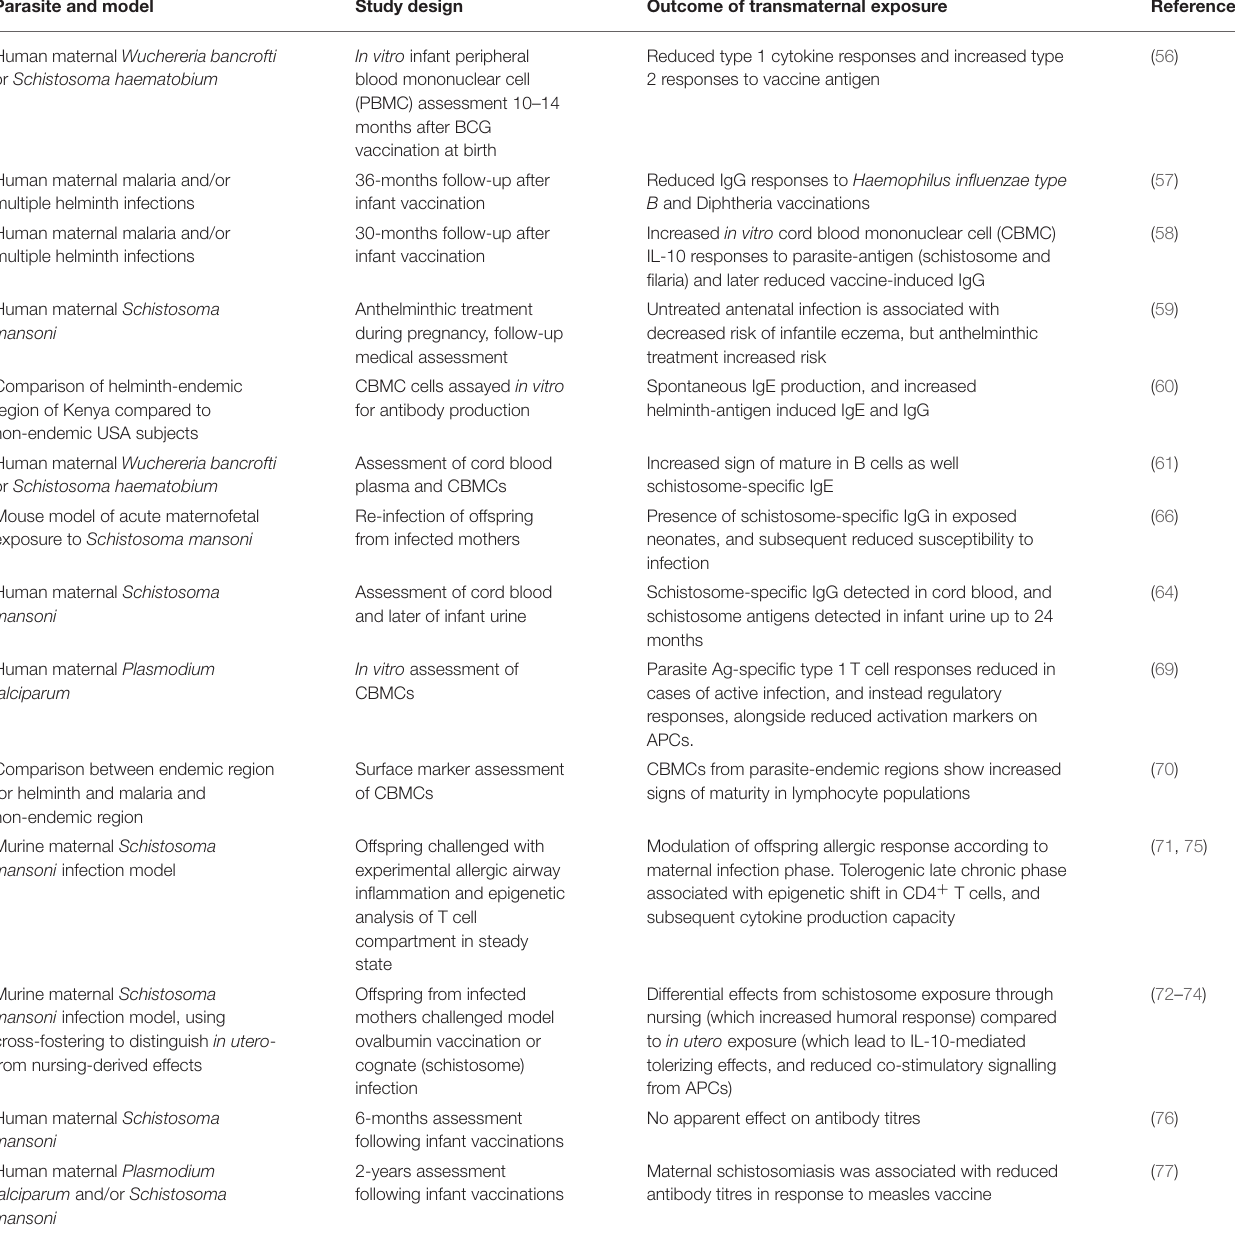
TABLE 1 | Overview of immunomodulation through maternal parasite